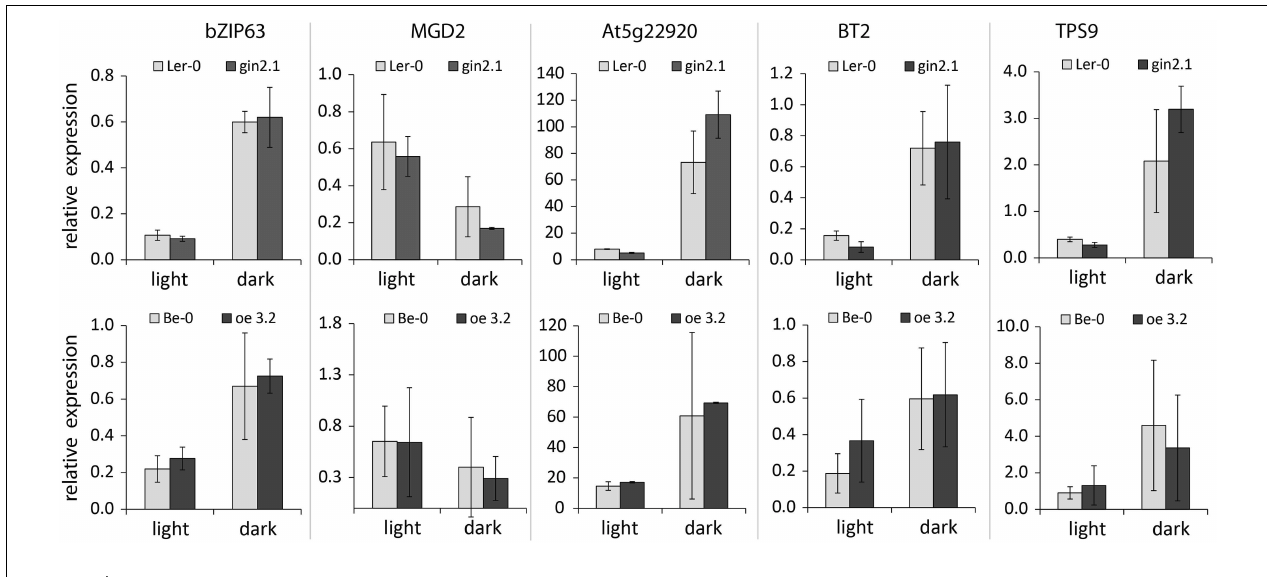
were taken both at the end of day and the end of a 6h extended night. The data represent the ratio of a given gene expression to the expression of the reference gene ( PP2A ). Significance: t